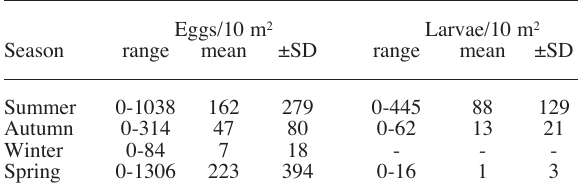
T ABLE 2. – Range, mean and standard deviation (SD) of anchovy egg and larva abundance by season in the Gulf of Tunis (from summer 2002 to spring